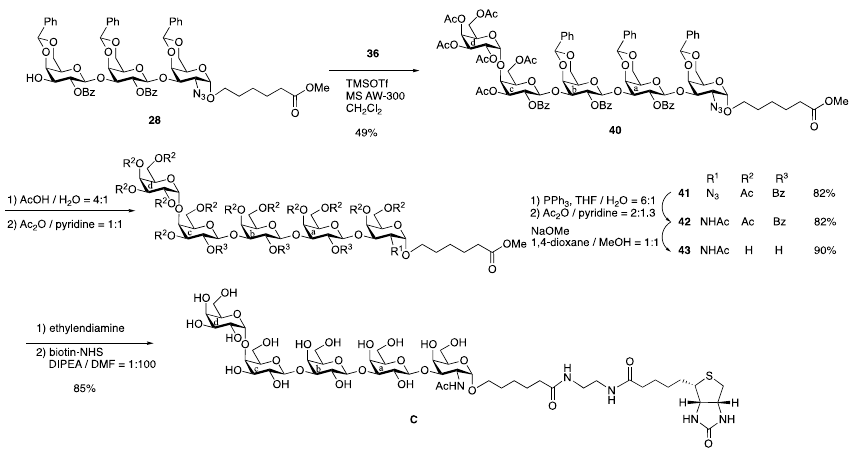
Figure 6. Synthetic strategy of tri- and